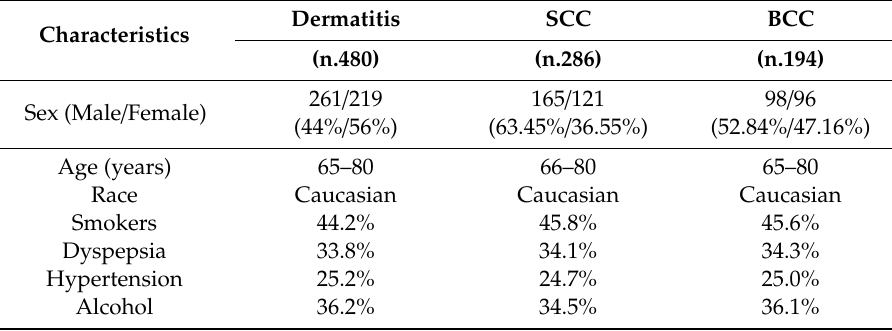
Table 1. Baseline clinical characteristics of the study